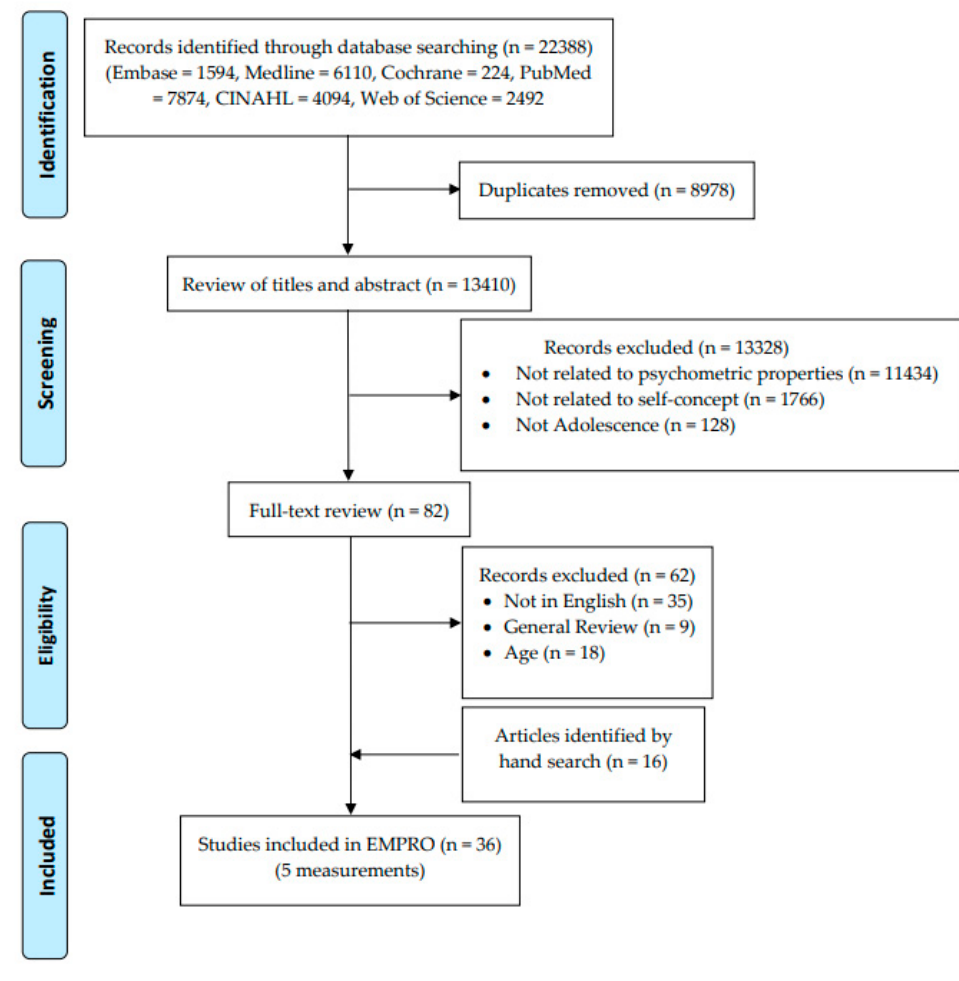
Figure 1. Flowchart of review process. Table 1. Summarized characteristics of the instruments identifying self-concept in adolescents.